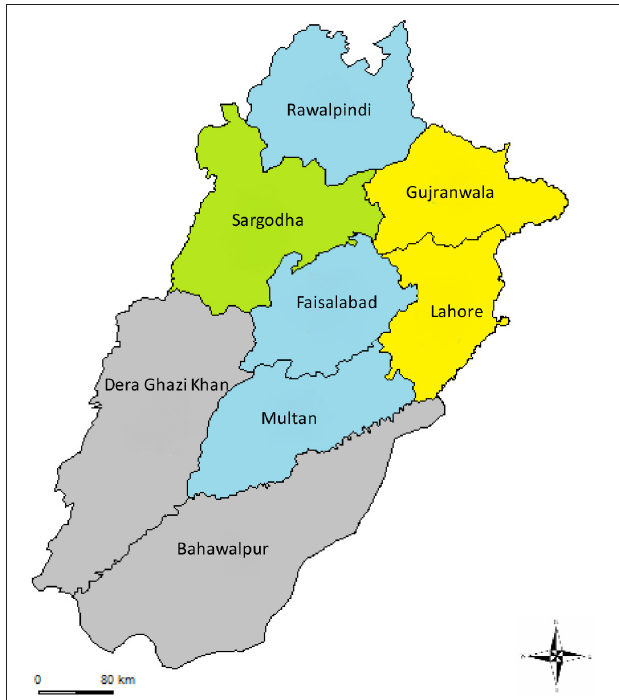
FIGURE 1 | Major (colored) and minor (gray) commercial chicken producing areas of Punjab, Pakistan. Yellow: major broiler producing areas, green: major layer producing areas, blue: both broiler and layer producing areas. Map has been downloaded from https://gadm.org/maps/PAK/punjab_2.html and modified according to our